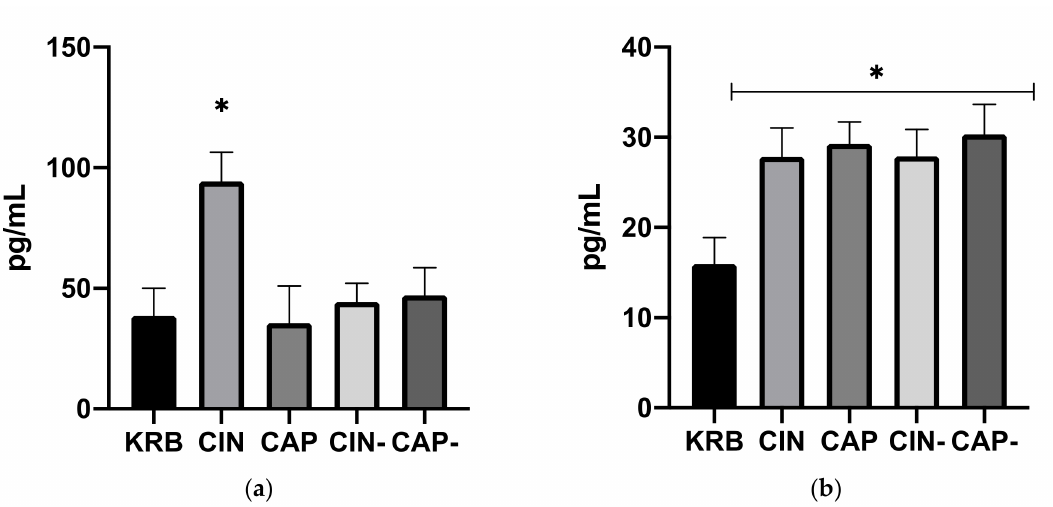
Figure 1. Effect of control KRB buffer (KRB), cinnamaldehyde (200 µ mol L − 1 , CIN), capsaicin (20 µ mol L − 1 , CAP), cin- namaldehyde (200 µ mol L − 1 ) + HC-030031(200 µ mol L − 1 ) (CIN-) and capsaicin (20 µ mol L − 1 ) + capsazepine (20 µ mol L − 1 ) (CAP-) on CCK ( a ) and GLP-1 ( b ) release. Significant differences compared to KRB are indicated with asterisks: * p < 0.05, number of replicates was n = 6, error bars express the